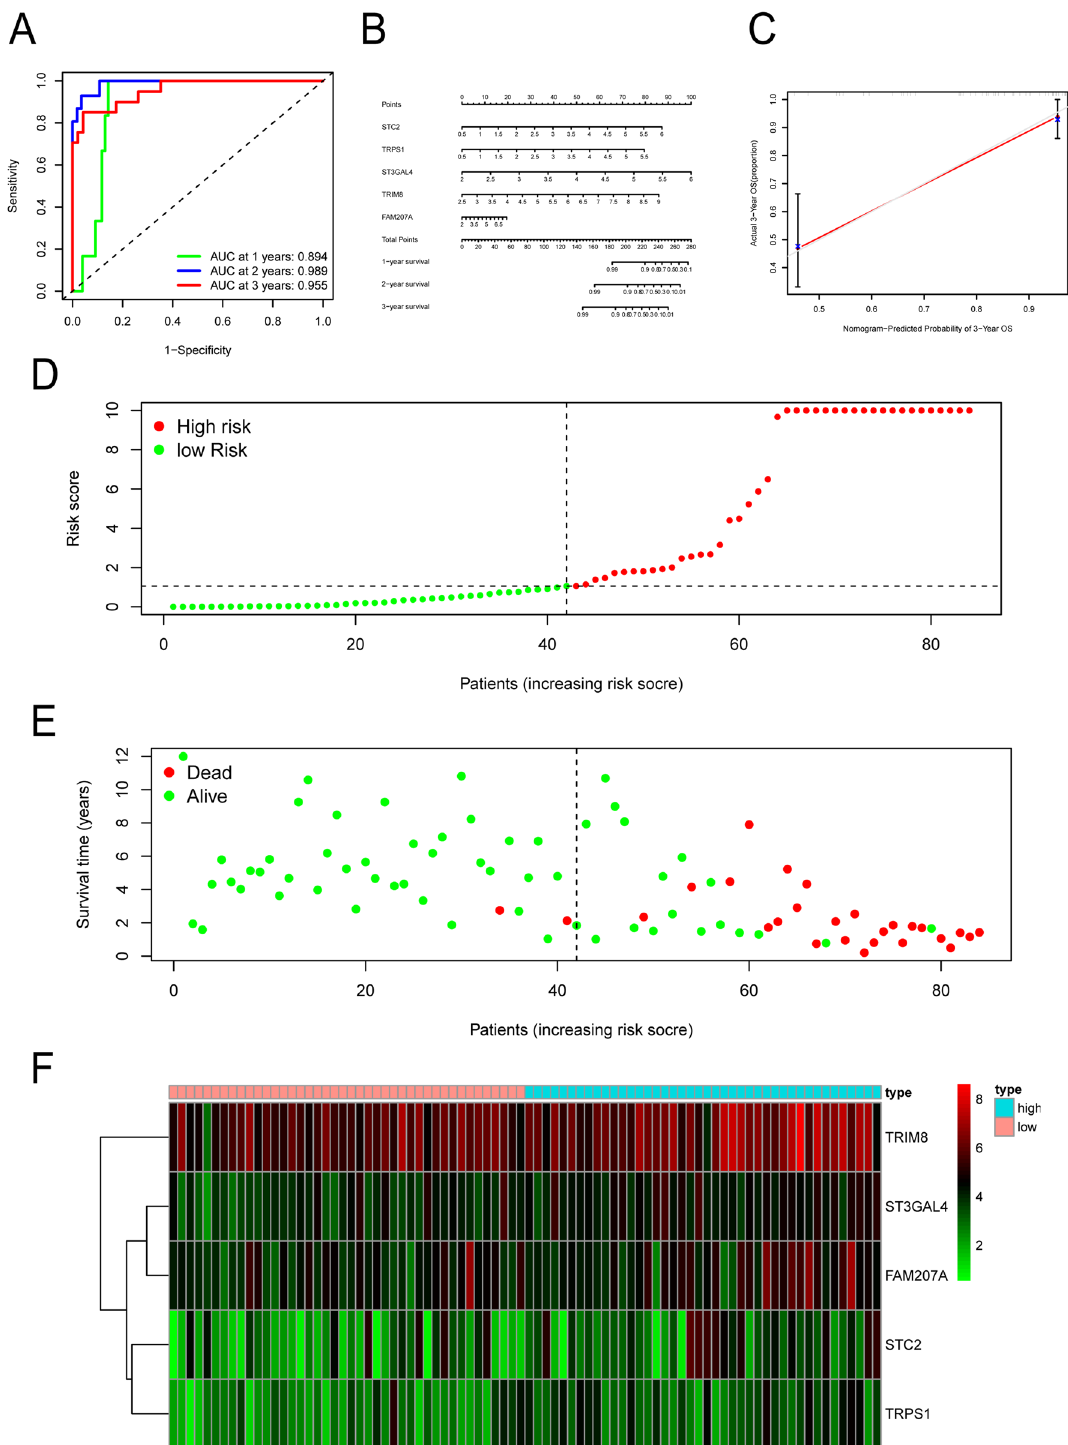
Figure 3. The prediction of the survival probability of the patients with osteosarcoma and the correlation between the expression levels of the five genes in the risk model. ( A ) ROC diagnostic curve. The AUC values used to predict the survival for one, two, and three years were greater than 0.8. ( B ) The nomogram of the five genes that were used to predict the survival for one, two, and three years, based on the model. ( C ) The calibration chart represents the predicted overall survival for three years. There was a good agreement between the actual and predicted survival rates. ( D ) The cases are ranked from low risk to high risk. ( E ) A scatter plot based on the time of death and risk of each case. ( F ) Heat map of risk showing the expression of the five genes from low risk to high risk; they all rise in